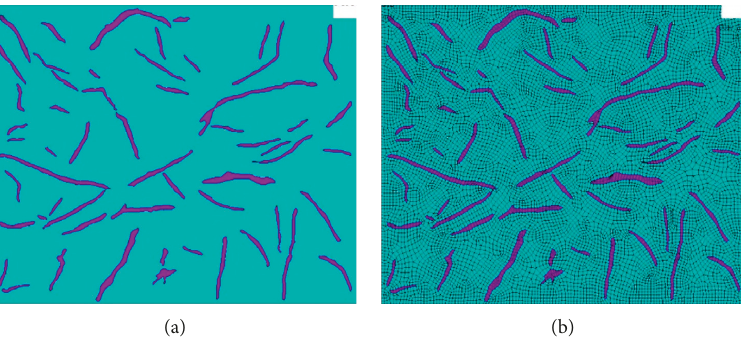
Figure 2: (a) FE model of grey iron; (b) meshing